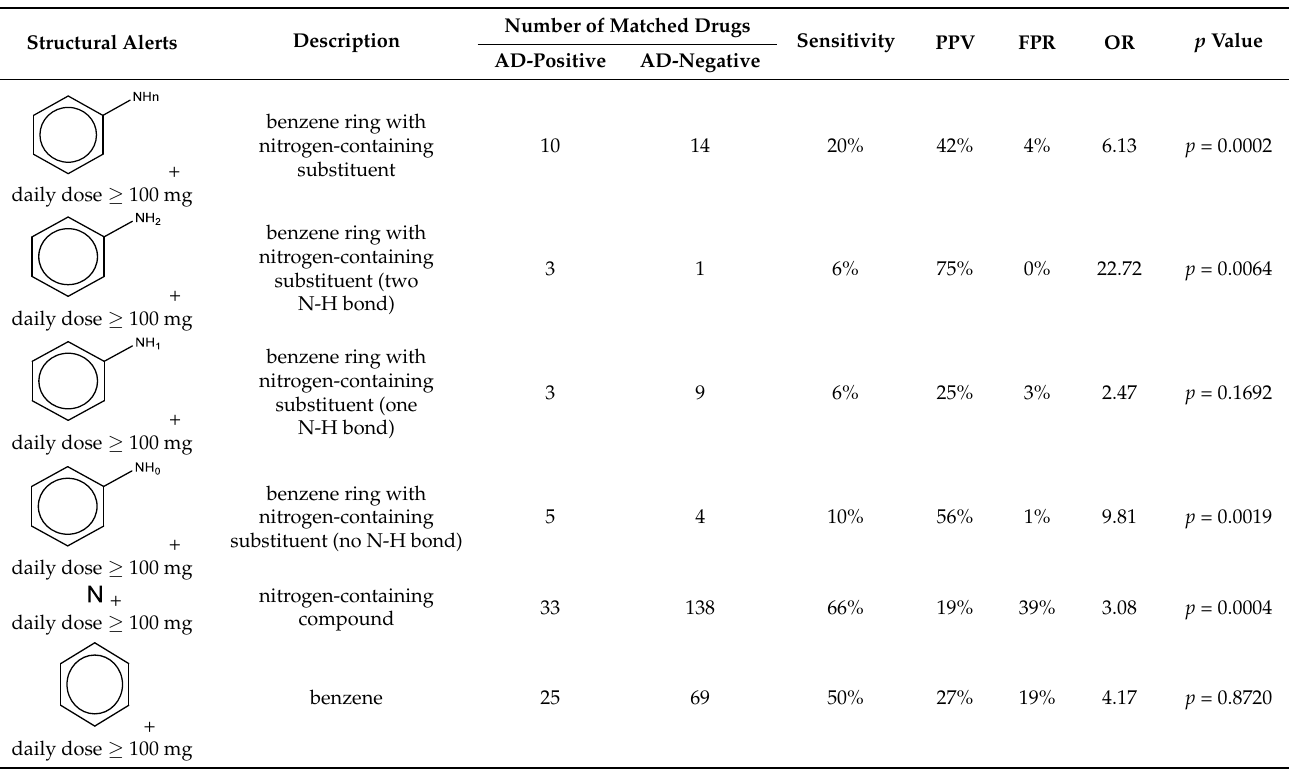
Table 2. Association between substructures matching benzene with nitrogen-containing substituent and drug-induced ADs after accounting for high daily dose (≥100 mg).